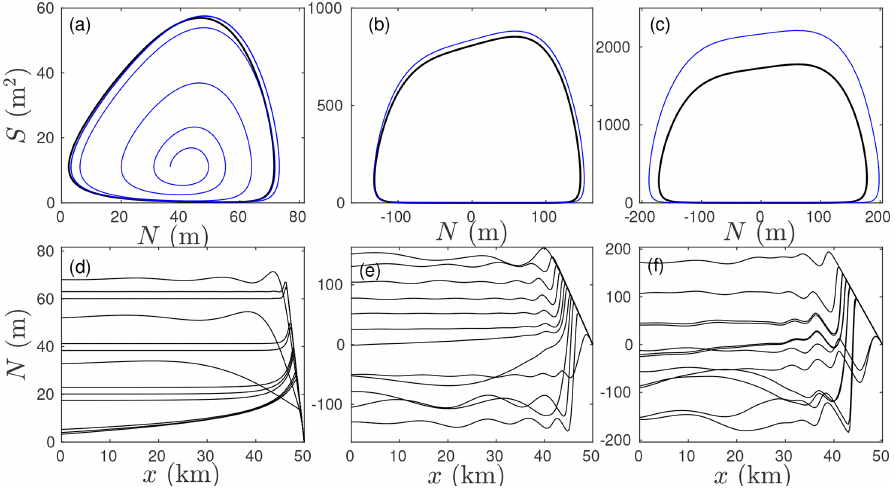
Figure 9. Each column represents one of the magenta markers in Fig. 8a. For each column, V p = 4km 2 and L = 50km, while q in = 10 . 9m 3 s − 1 (panels a and d , marker A in Fig. 8.), 218.4m 3 s − 1 (panels b and e , marker B) and 655m 3 s − 1 (panels c and f , marker C). The top row (a–c) displays phase planes of (N( 0 ,t),S( 0 ,t)) for the full model (1) (blue) superimposed on the phase plots for the lumped model (2) (black). The bottom row shows snapshots of N(x,t) against x for periodic solutions of the full model at intervals of 93d (d) , 5.5d (e) and 4.6d (f)